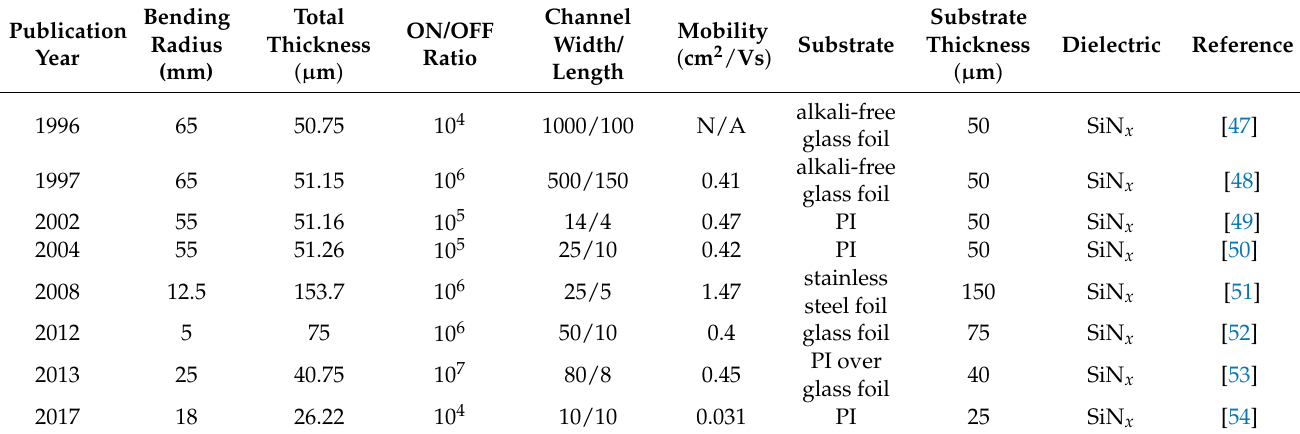
Table 1. The detailed properties of the a-Si:H TFTs in Figure